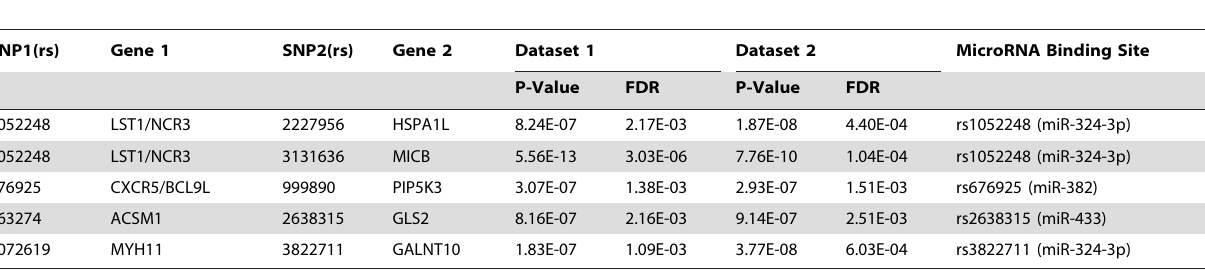
Table 5. Five pairs of interacting SNPs, one of which falls in the microRNA binding region.